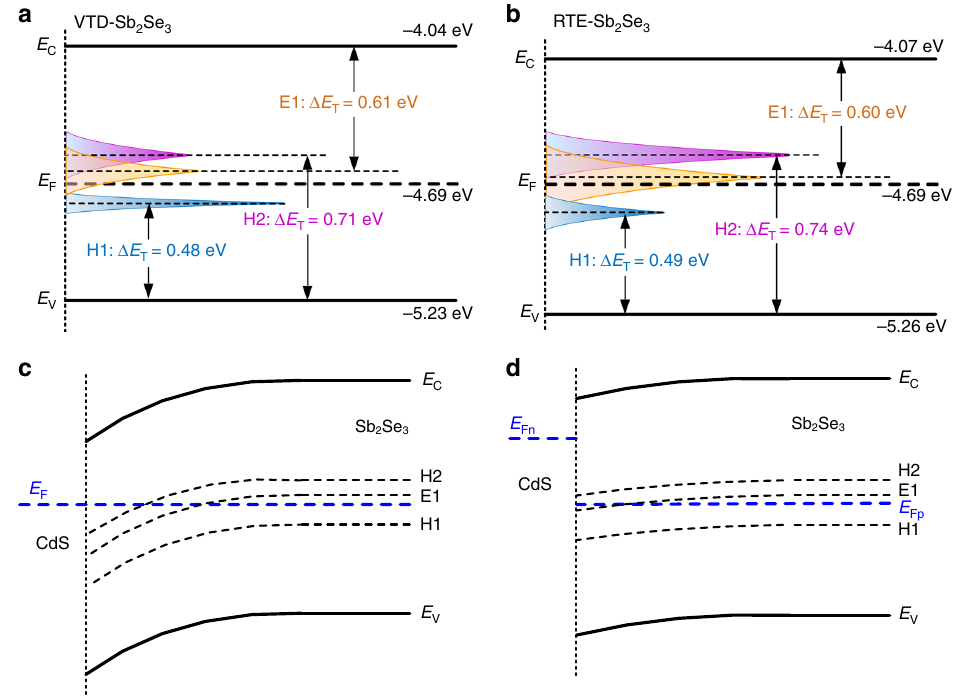
Fig. 6 In fl uence of defect levels on the CdS/Sb 2 Se 3 solar cells. Energy states and defect level of a VTD-fabricated and b RTE-fabricated Sb 2 Se 3 fi lms. Energy band diagrams at CdS/Sb 2 Se 3 interface c in the dark and d under